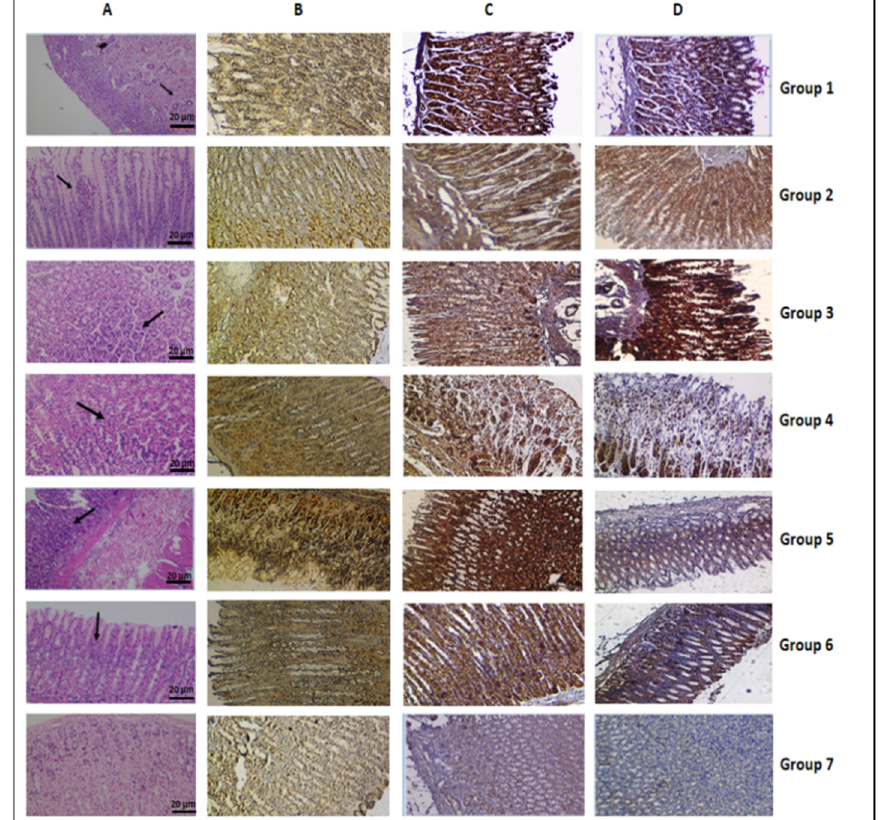
Figure 3. The histopathological examination of stomach tissue in all groups of rats (magnification × 200). ( A ) H&E-stained sections; IHC-stained sections for the caspase 9 ( B ), Bax ( C ), and Bcl-2 ( D ) proteins (magnification × 200), respectively.